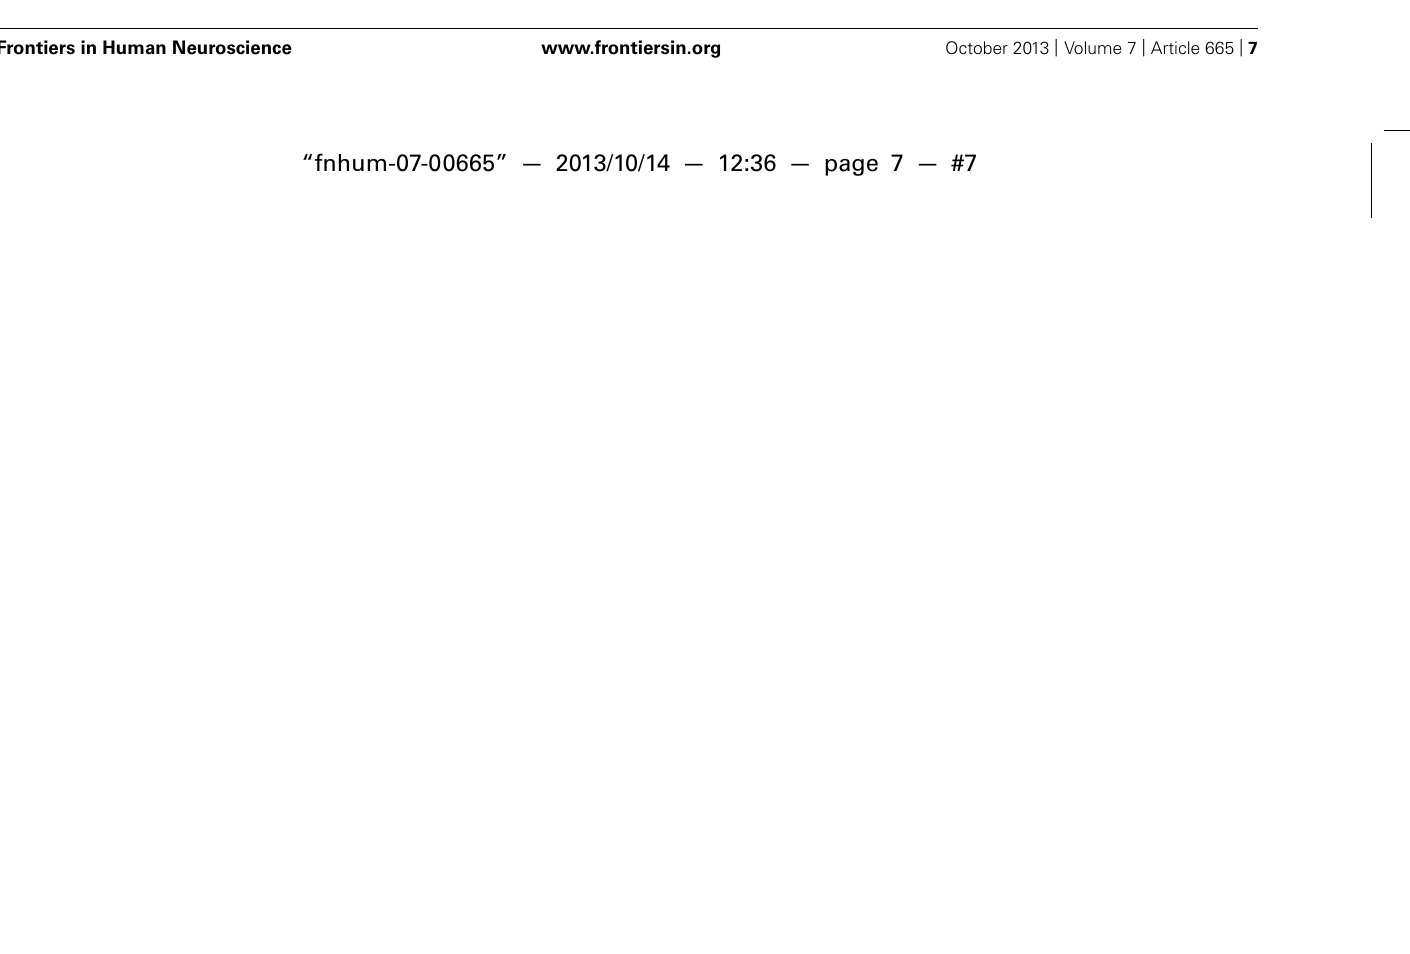
FIGURE 2 |The mean and standard error of the mean of each speaker group’s inter-syllable intervals (ISIs,A) and speech error rates (B) . In the hypokinetic group, the means and standard error of the means were derived from the data of the hypokinetic speakers with Parkinson’s disease. In each plot, data from the hypokinetic speaker with multiple system atrophy (MSA, gray diamond) and the speaker with corticobasal degenera- tion (CBD, gray square) are indicated